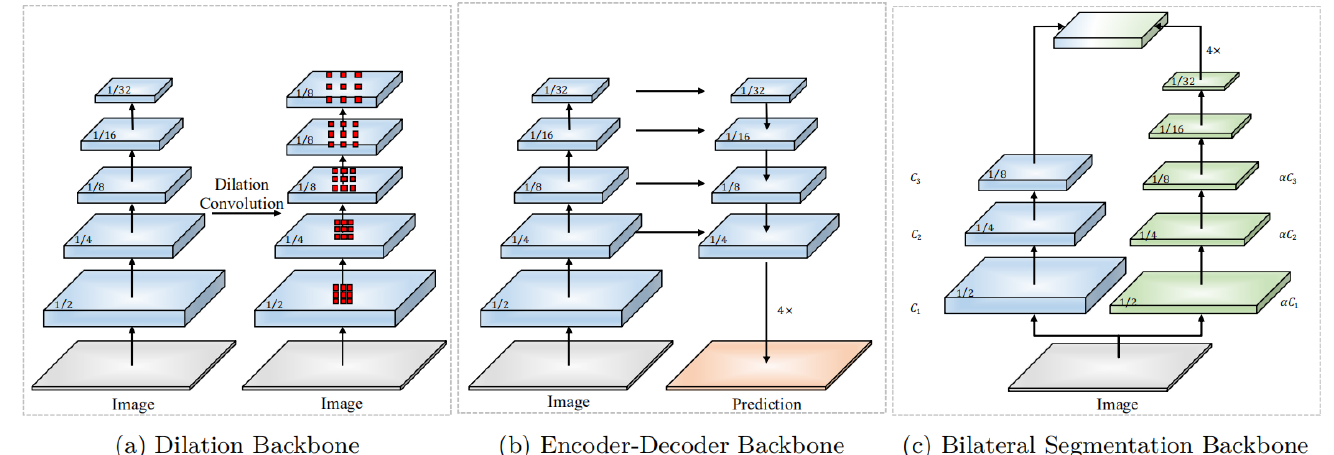
Figure 1. Three types of backbone. ( a ), Dilation Backbone; ( b ), Encoder-Decoder Backbone; ( c ), Bilat- eral Segmentation Backbone. Graph from Changqian Yu, BiSeNet V2: Bilateral Network with Guided Aggregation for Real-time Semantic Segmentation